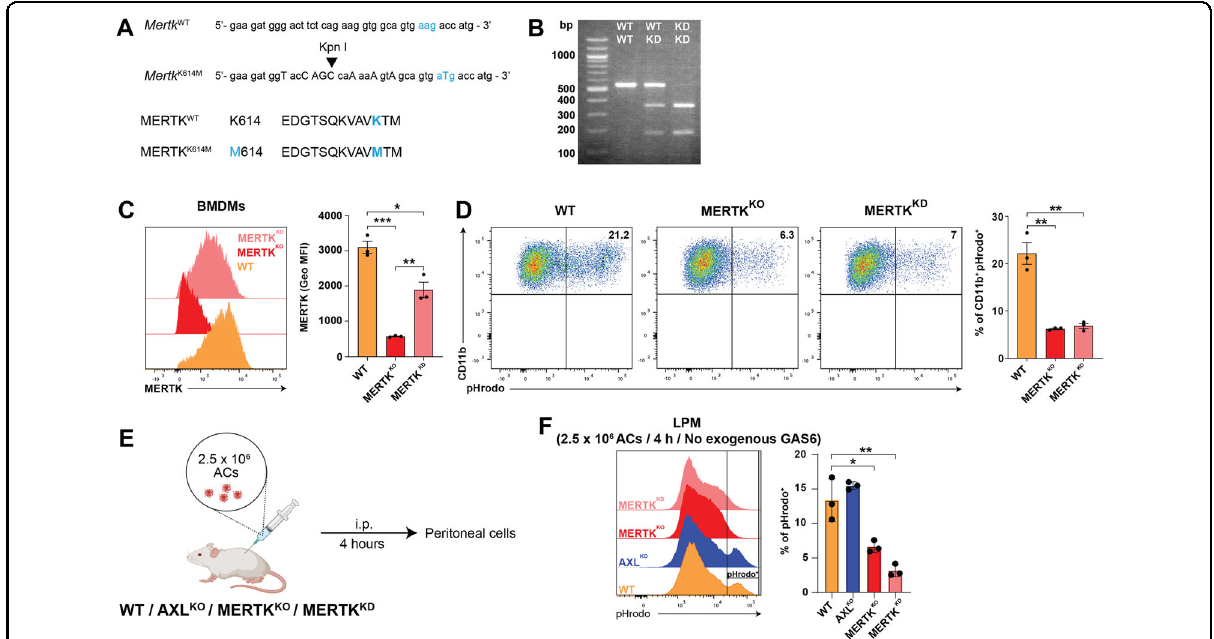
Fig. 4 MERTK kinase activity is essential for clearance of apoptotic cells in vivo. A (top) targeted codon in Mertk for the generation of Mertk K614M/K614M is indicated in blue. A KpnI restriction enzyme site was engineered to aid PCR-based genotyping. (bottom) Amino acid sequence of the targeted region, indicating the introduced mutation at Lysine (K) 614 for Methionine (M) 614. B Diagnostic PCR results, after DNA ampli fi cation and digestion with KpnI. The WT allele yields one 548 bp product and the mutant allele yields a 184 and a 364 bp band. C Representative histograms showing expression of MERTK in bone marrow-derived macrophages from mice with the indicated genotypes. Bar graphs show geometrical mean fl uorescence of MERTK. Shown is mean with SEM and individual samples. D Representative fl ow cytometric analysis of efferocytosis with bone marrow-derived macrophages from mice with the indicated genotypes. Macrophages and ACs were co-incubated for 1 h in the presence of serum at a ratio of 1:6 and analyzed afterwards for pHrodo signal. Bar graphs show mean with SEM and individual samples. E Experimental set-up to study contribution of AXL and MERTK for efferocytosis in the murine peritoneum. ACs (2.5 × 10 6 ) were injected intraperitoneally into mice of indicated genotype. After 4 h PECs were analyzed via fl ow cytometry. Created with BioRender.com. F Representative histograms for pHrodo-Red upon injection of ACs into mice of indicated genotype (Gated on CD19 − , Ly6G − , and F4/80 + live cells). Frequency of pHrodo + cells. Bar graphs show mean with SD and individual samples. Data were representative of two individual experiments ( n = 3 –